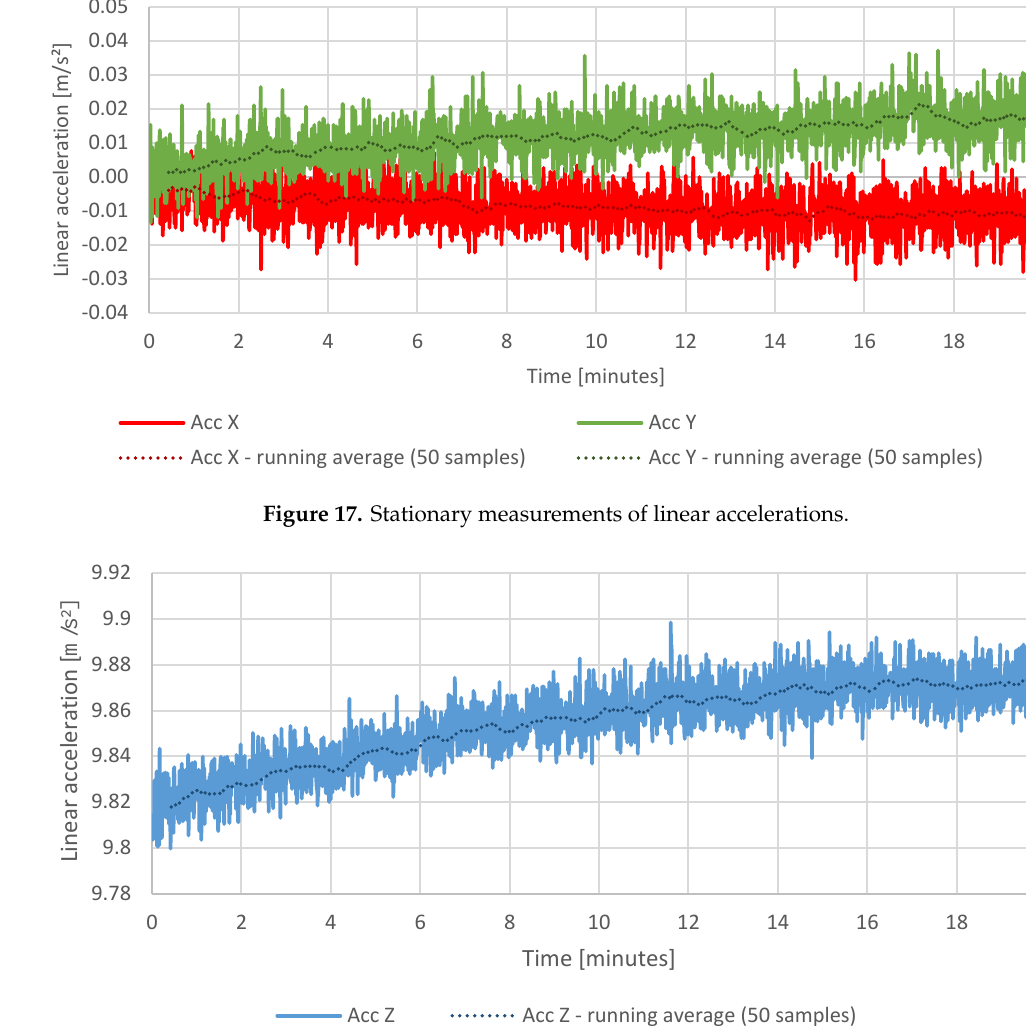
Figure 19. Stationary measurements of estimated roll and pitch angles.